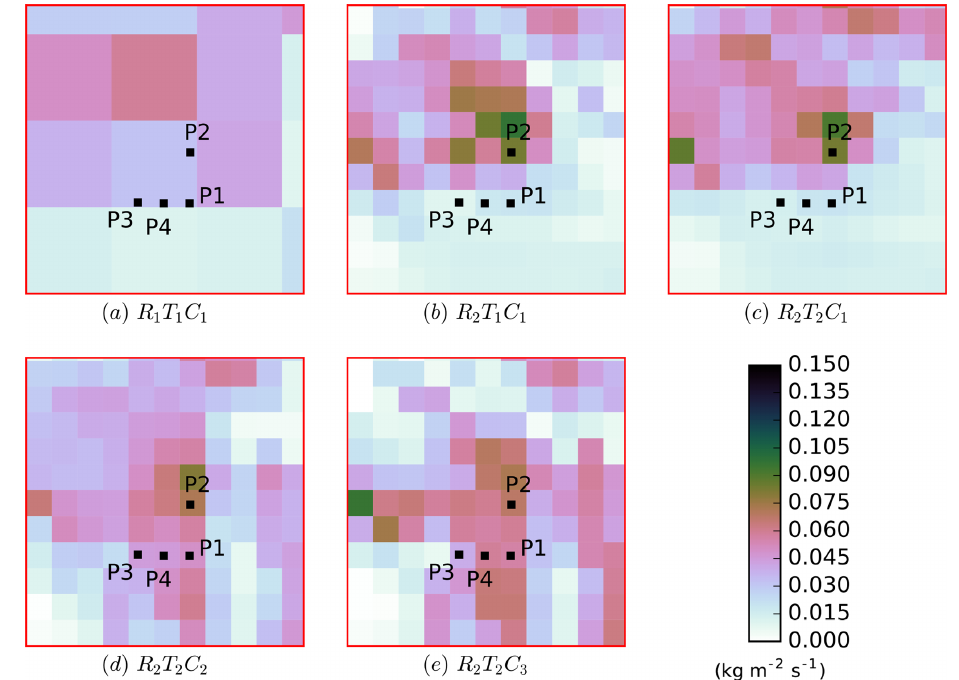
Figure 13. Cumulated runoff during the September 2015 event for R 2 T 1 C 1 –R 2 T 2 C 3 and the locations of points P1–P4.